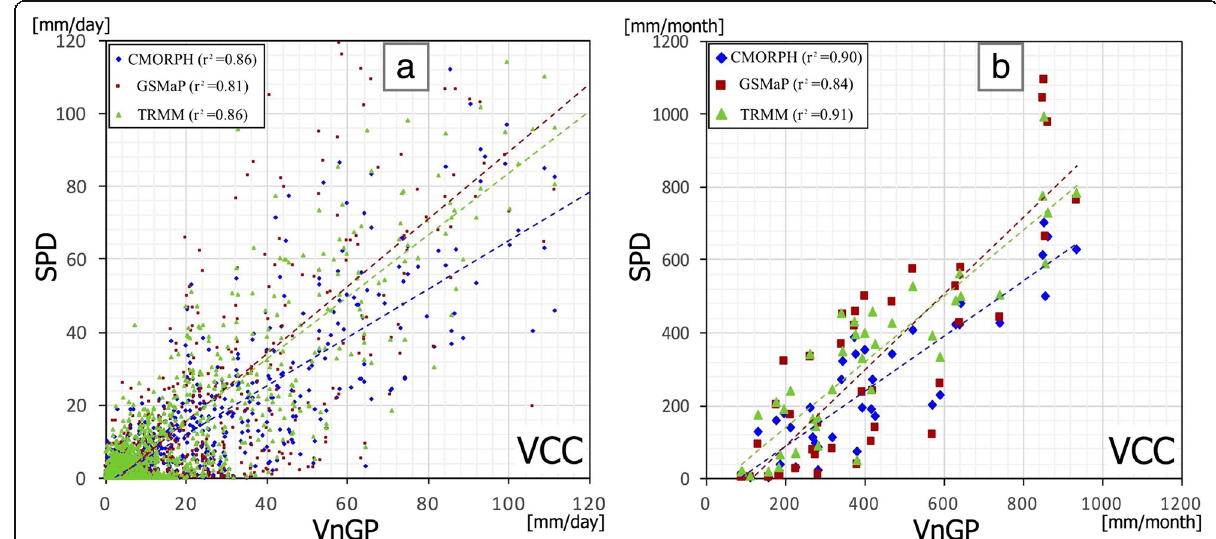
Fig. 7 a , b Same as Fig. 4, except for SOND rainfall over the VCC. Sample numbers are N = 1220 for each scatter plot of daily values and N = 40 for monthly values